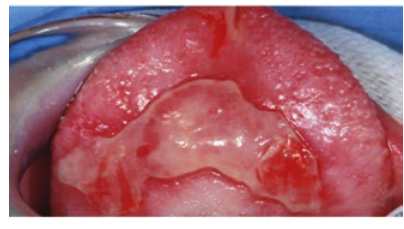
Figure 1. Tongue leukoplachia.